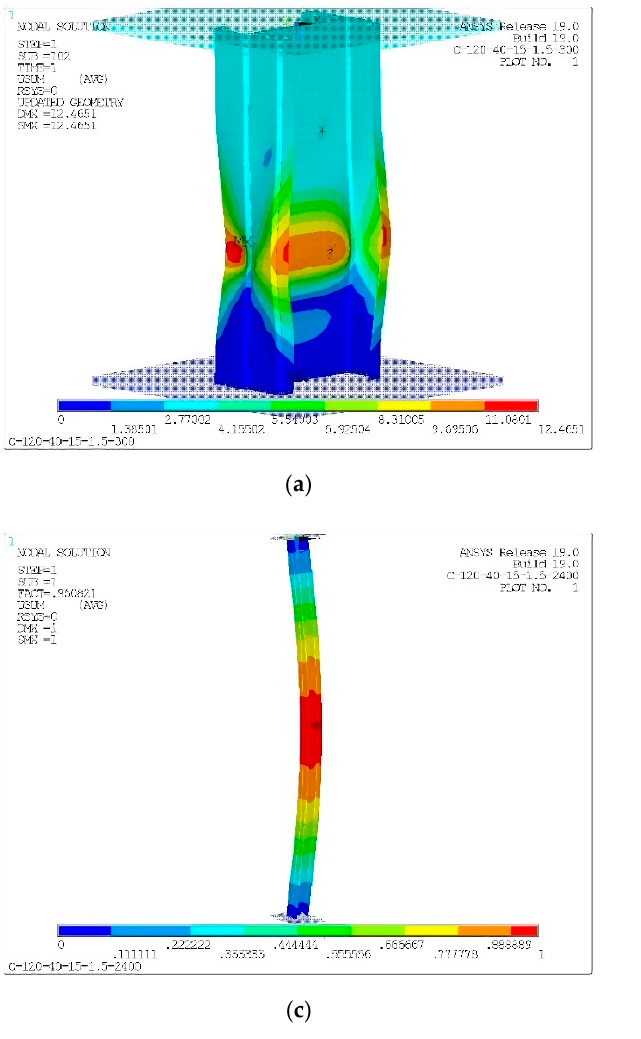
Figure 8. Deformation of the C120-40-15-1.5- L combined columns ( a ) C120-40-15-1.5-300; ( b ) C120-40-15-1.5-1500; ( c ) C120-40-15-1.5-2400; ( d ) C120-40-15-1.5-3000.